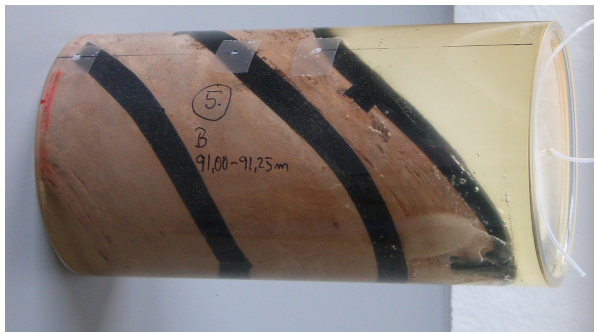
Figure 7. Bunter sandstone drill core. Adhesive tape, preventing intrusion of the resin, indicates the direction of the fractures (image taken from Wolf,